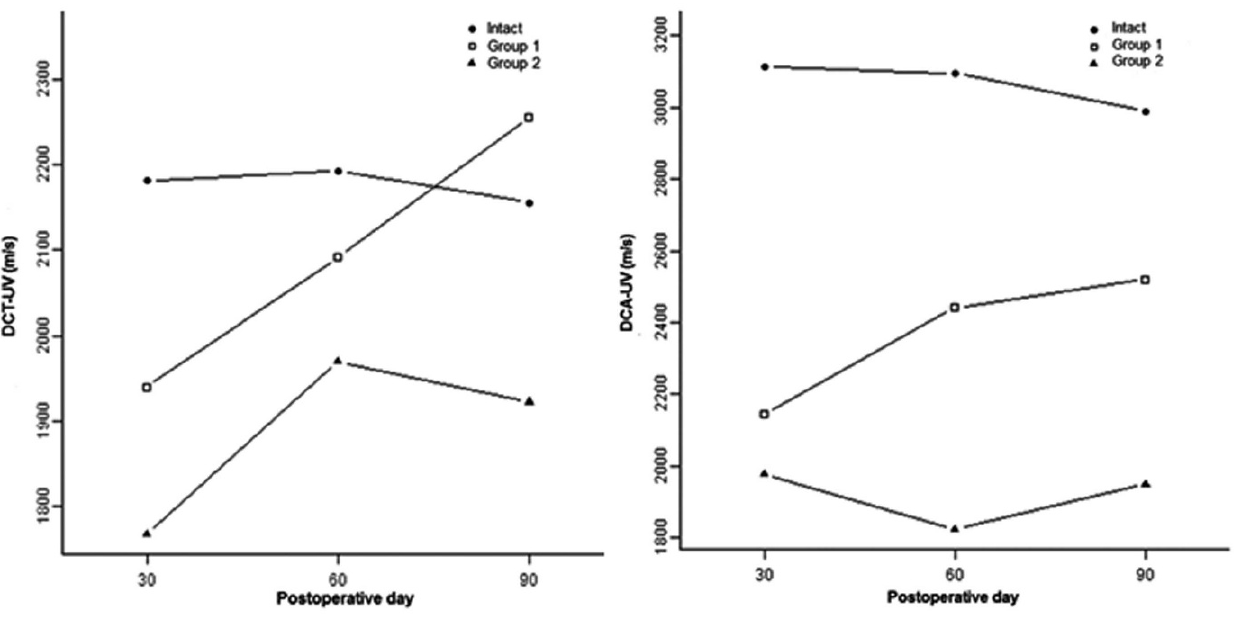
Figure 4 - Plot of the transverse (left) and axial (wright) ultrasound velocity (m/s) according to group and postoperative period. In both graphs, the data show normal bone, Group 1 and Group 2 from top to